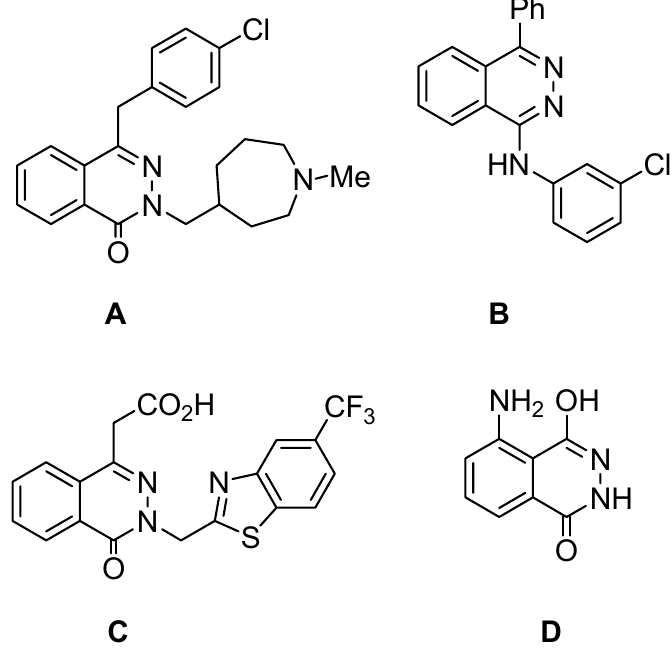
Figure 1. Phthalazine derivatives (azelastin, MY 5445, zopolrestat and